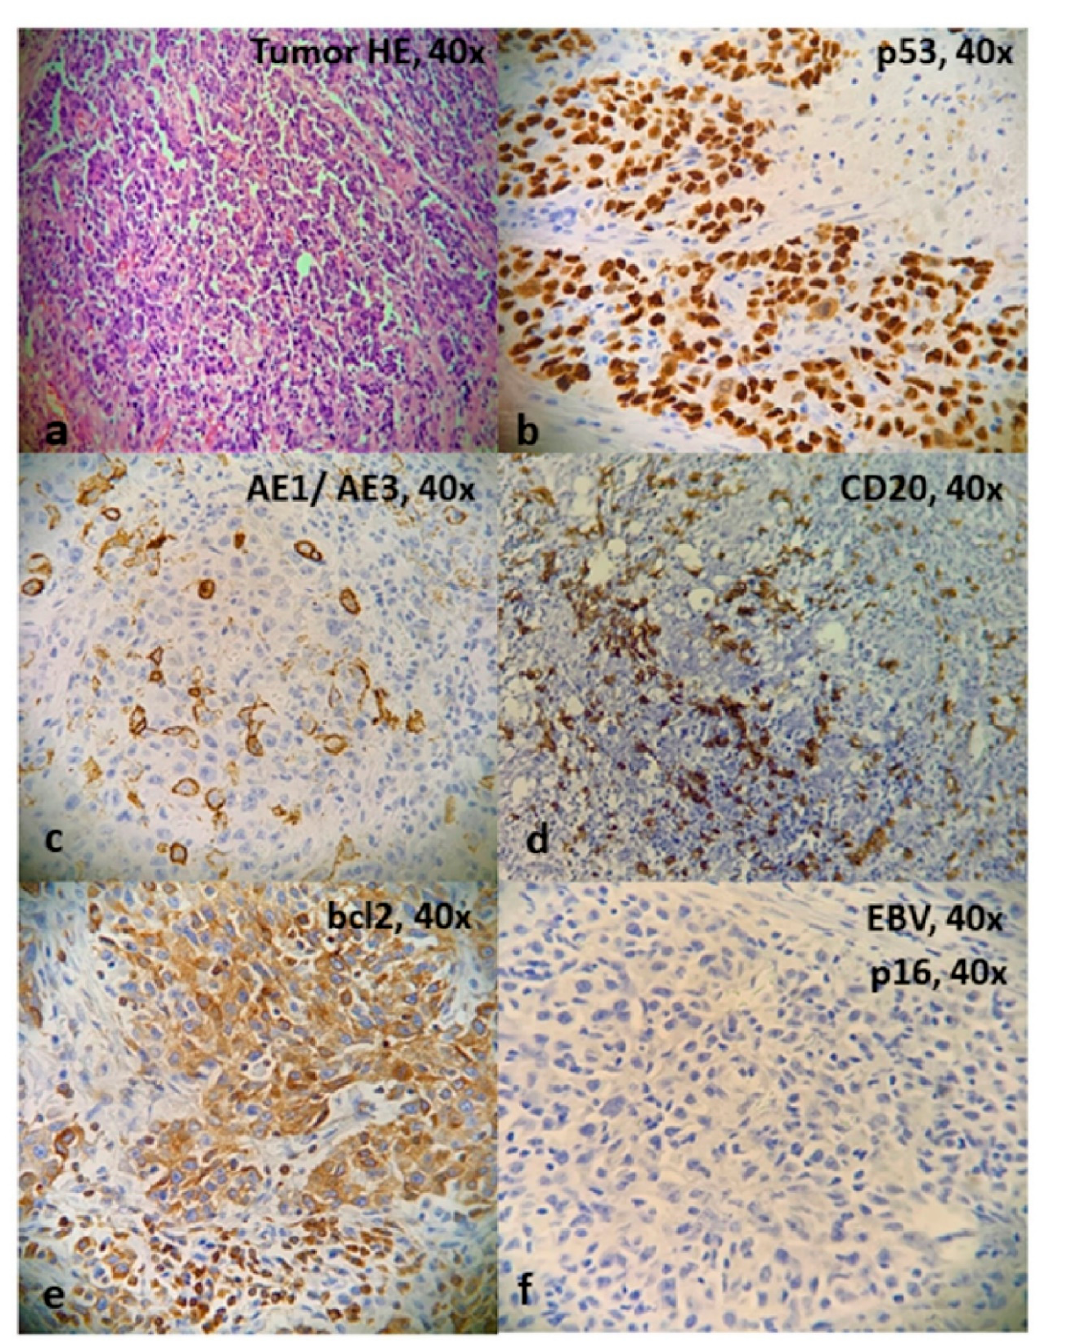
Figure 7. ( a ) Cells present in solid nests with pleomorphic appearance. Clear cell nuclei are seen with prominent nucleoli. ( b ) p53 association with >80% mutated cells. ( c ) Immunohistochemistry was positive for AE1/AE3. ( d ) Immunohistochemistry was negative for CD20. ( e ) Strong staining for bcl-2. ( f ) No evidence of p16 was found with immunochemistry.